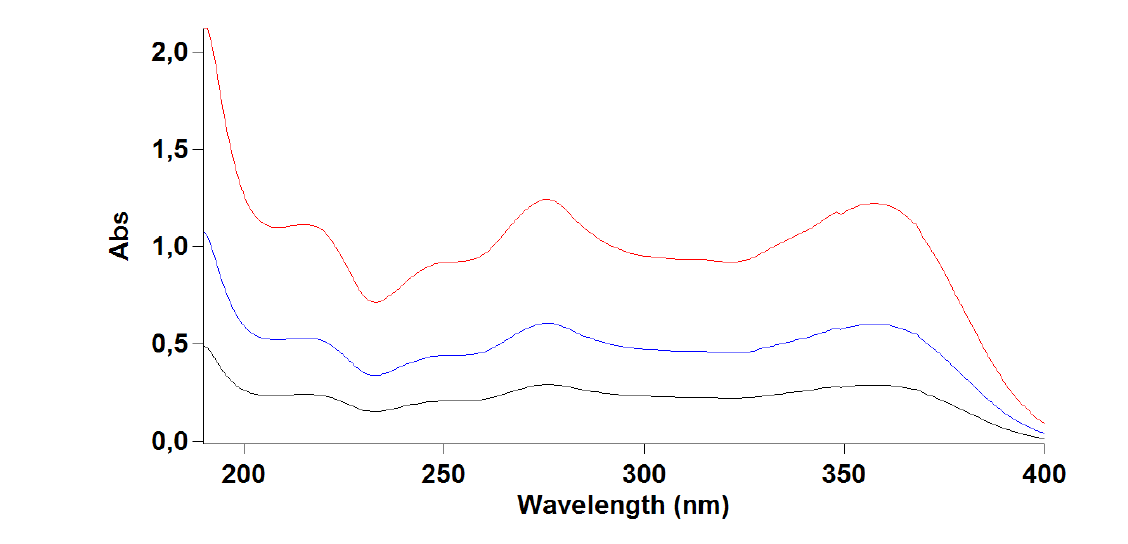
Figure 14. UV-Vis absorption spectra of tetracycline in different concentrated aqueous solutions: 40, 20, 10 ppm showing pH values of 4.1, 4.4, 4.8, respectively (from top to